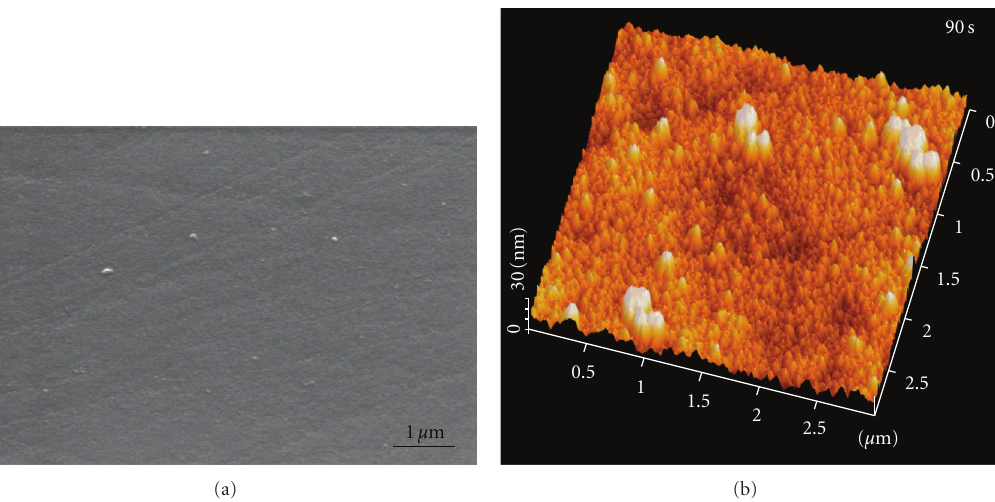
Figure 1: FE-SEM image (a) and AFM image (b) of ULPt(90s). FE-SEM image was observed at 30,000 magnification, and AFM image was observed in 3 μ m × 3 μ m range.